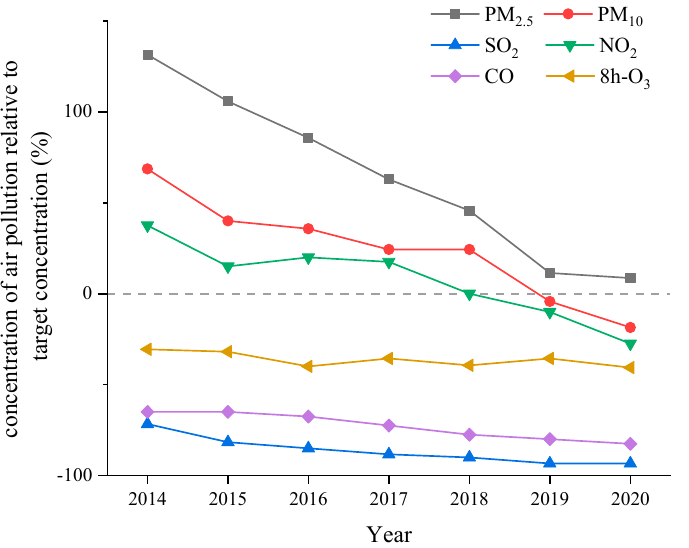
Figure 1. Annual average concentrations of six air pollutants in Beijing in 2014–2020, as percentages of change compared with the Chinese national ambient air quality standard. Note: The dashed line denotes the Chinese national ambient air quality standard. Values are the percentage increase or decrease of each concentration relative to the standard value (0%). The standards and the measured data are all the daily average.